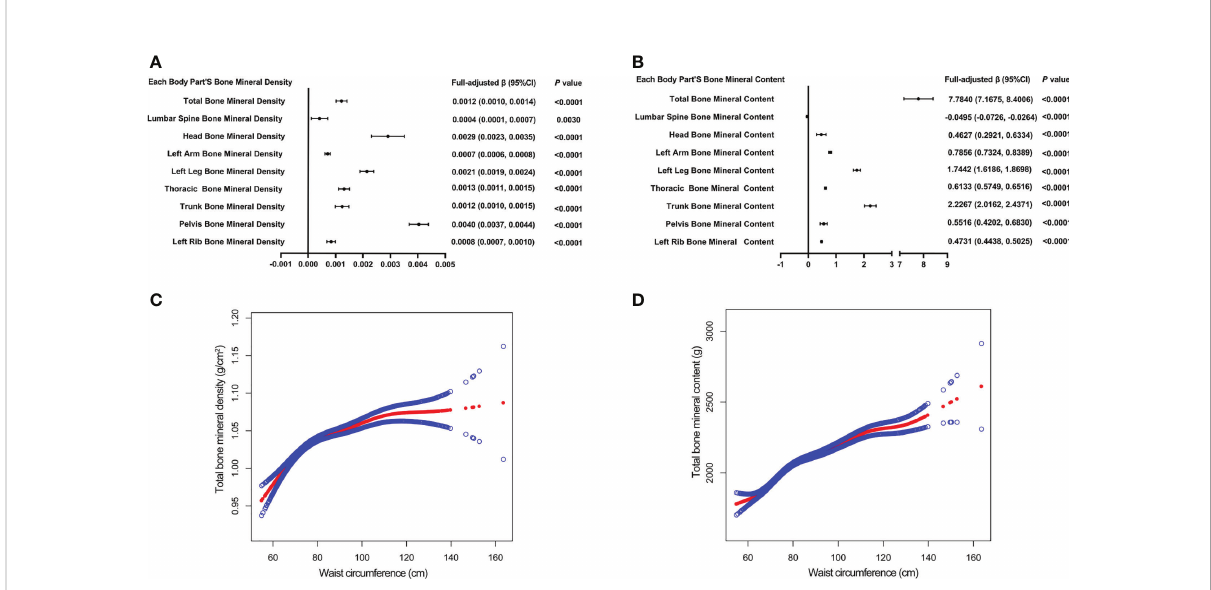
FIGURE 3 The forest plots of each body part ’ s bone mineral density or bone mineral content and waist circumference, respectively (A, B) . Association of total bone mineral density and bone mineral content with waist circumference (C, D) . The solid red line represents the smooth curve fi t between variables. Blue bands represent the 95% con fi dence interval from the fi t (C, D) . All confounding factors were adjusted.